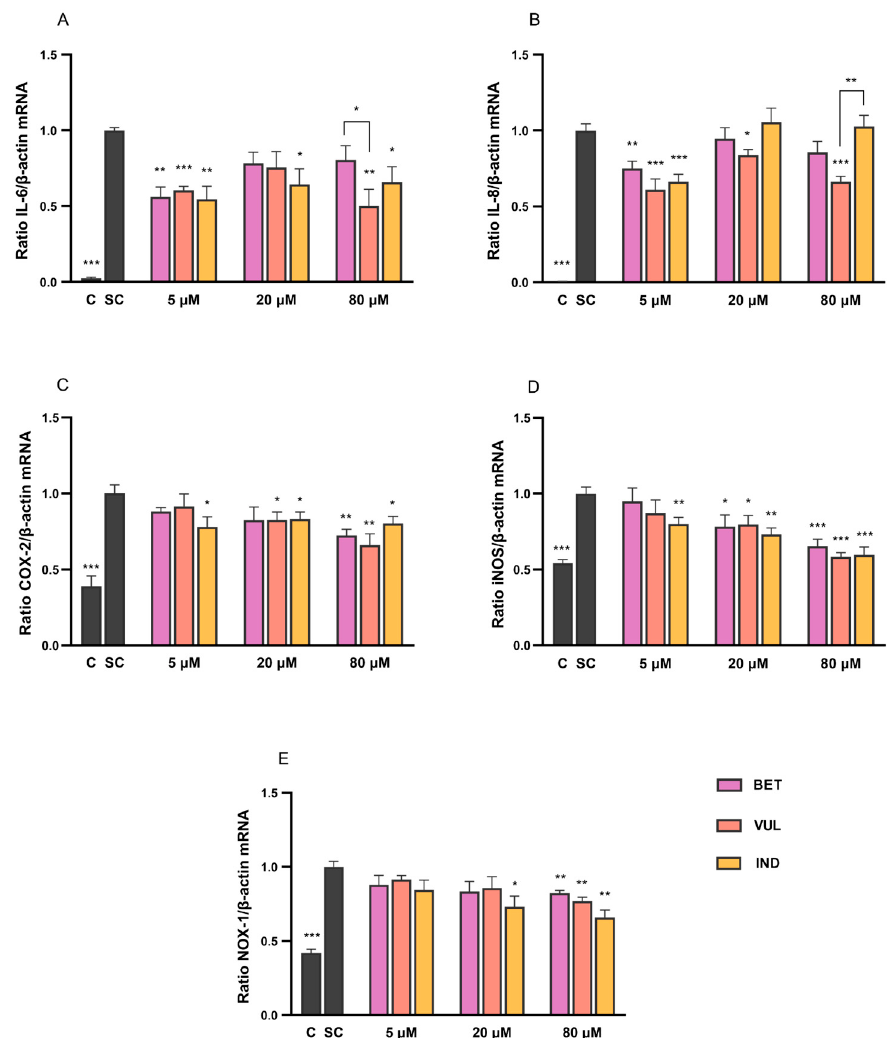
Figure 2. Effects of BET, VUL and IND (5, 20 and 80 µ M) on mRNA levels of ( A ) IL-6, ( B ) IL-8, ( C ) COX-2, ( D ) iNOS and ( E ) NOX-1 following 6 h cytokine stimulation in Caco-2 cells. C and SC refer to negative medium control and cytokine-stimulated control, respectively. Data are mean with SEM of 3 replicates from independent cell experiments. Non-bridged asterisks indicate significant difference of treatment vs. SC: * p < 0.05, ** p < 0.01, *** p < 0.001.